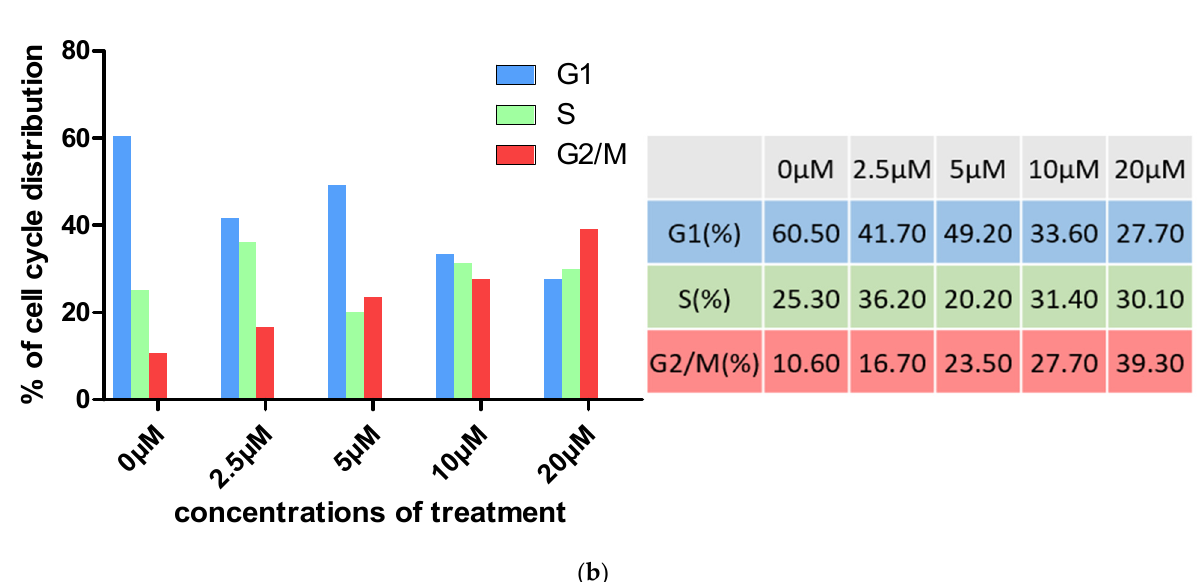
Figure 4. Effects of compound 9b on MCF7 cell cycle progress for 24 h. ( a ) Treatment of MCF7 cells with compound 9b at different concentrations (0 μ M, 2.5 μ M, 5 μ M, 10 μ M, 20 μ M) for 24 h. ( b ) Quantitative analysis of cell cycle.